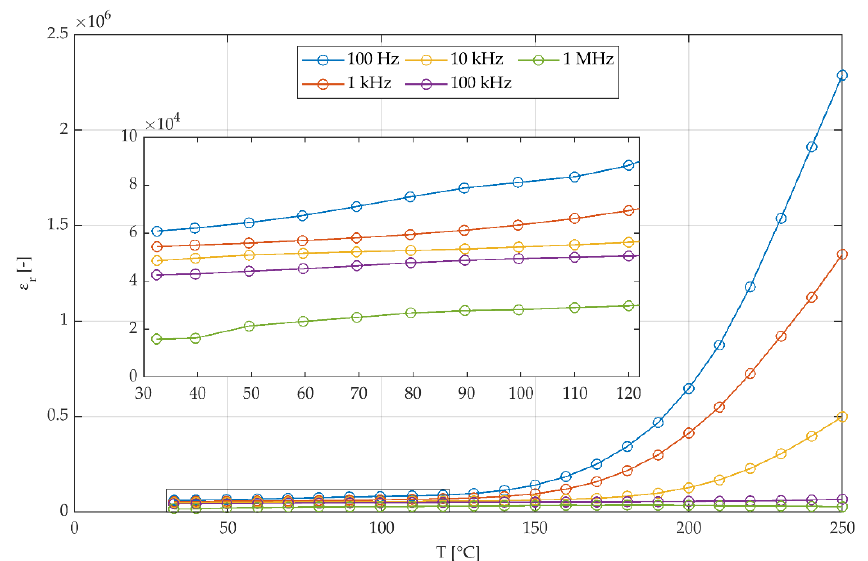
Figure 13. Dependence of relative permittivity on temperature for five selected frequencies in sample H .